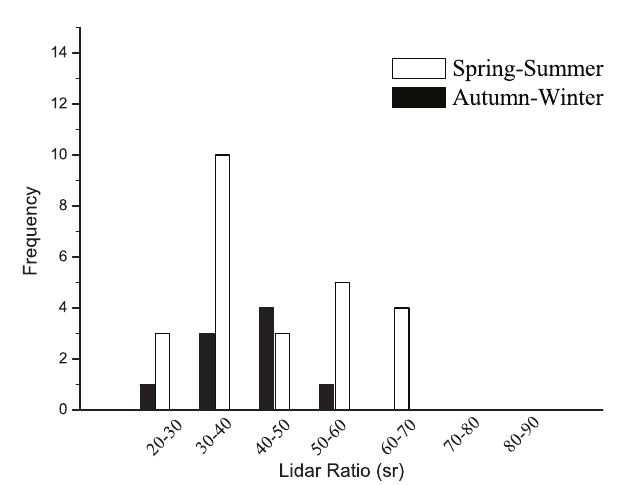
Fig. 10. Frequency of the monthly averaged lidar ratio values at 355 nm for both spring-summer (April-September) and autumn-winter (October- March)